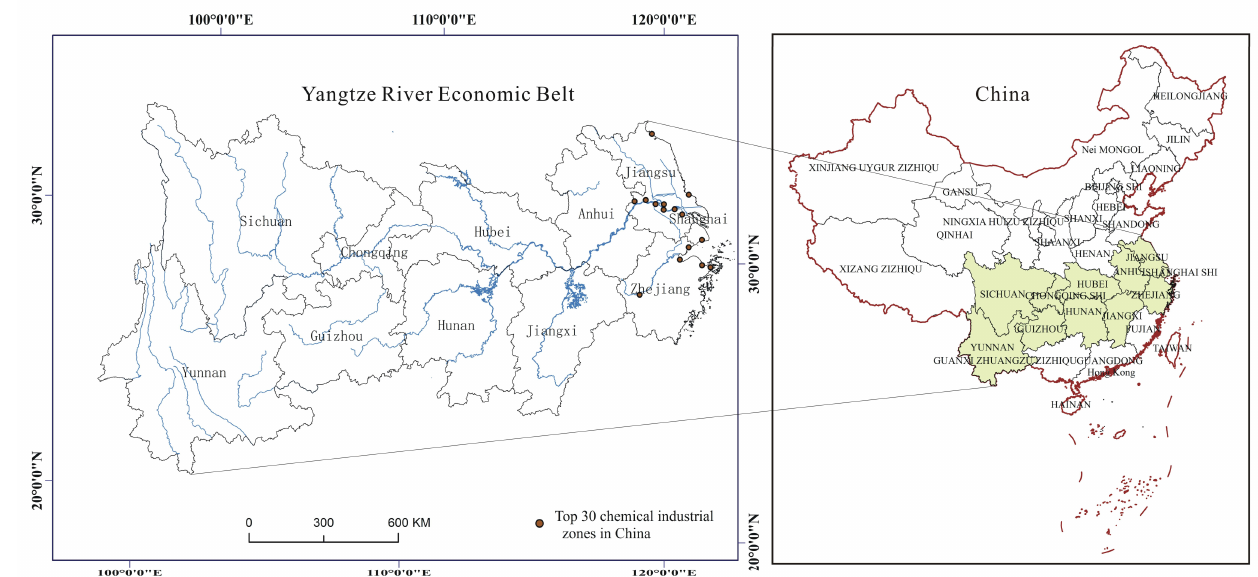
Figure 1. Map of the Yangtze Economic